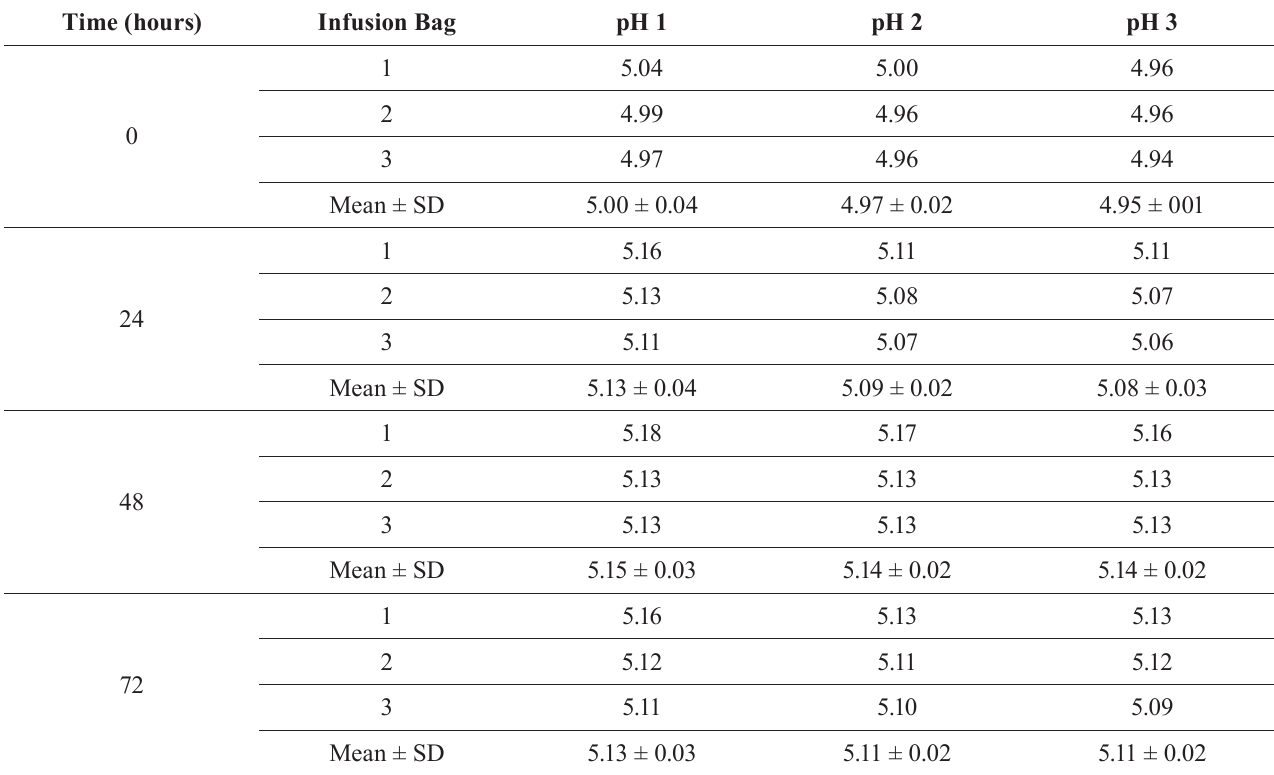
TABLE VI - pH values obtained at times 0 h, 24 h, 48 h and 72 h Time